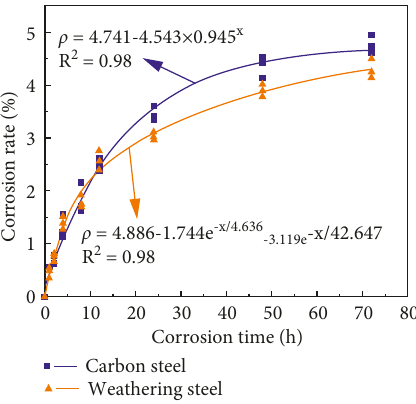
Figure 4: Corrosion dynamic